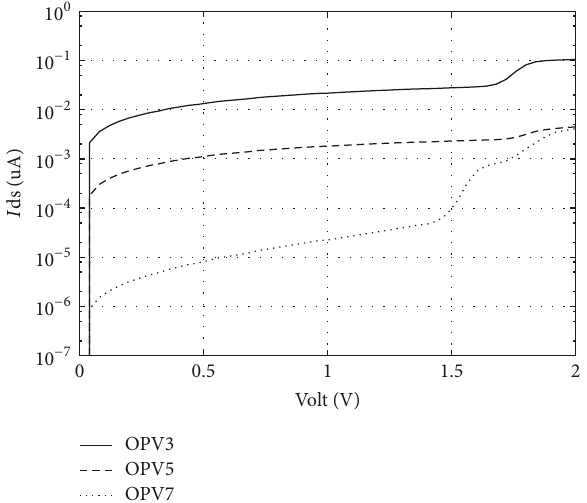
Figure 14: Impact of molecule length on 𝐼 - 𝑉 curves.